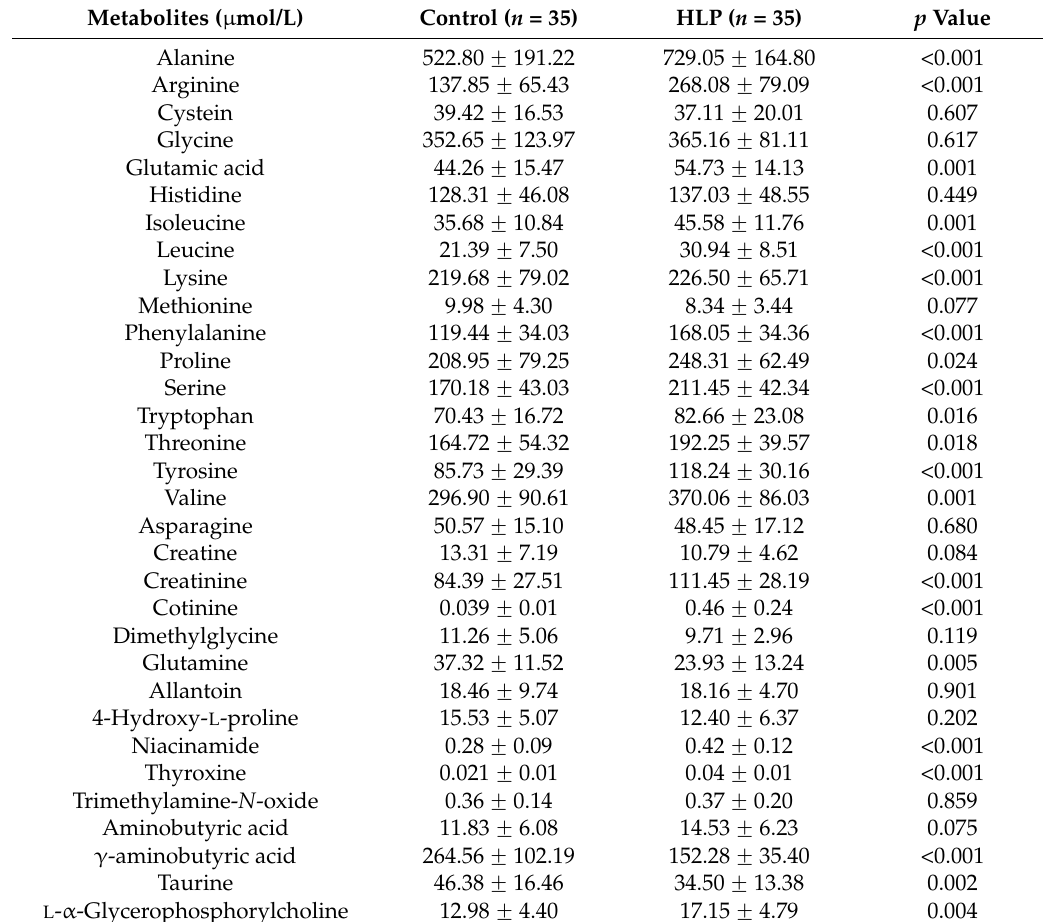
Table 2. Quantitative analysis of amino acids, biogenic amines and fatty acids in the fasting serum between the healthy control and HLP